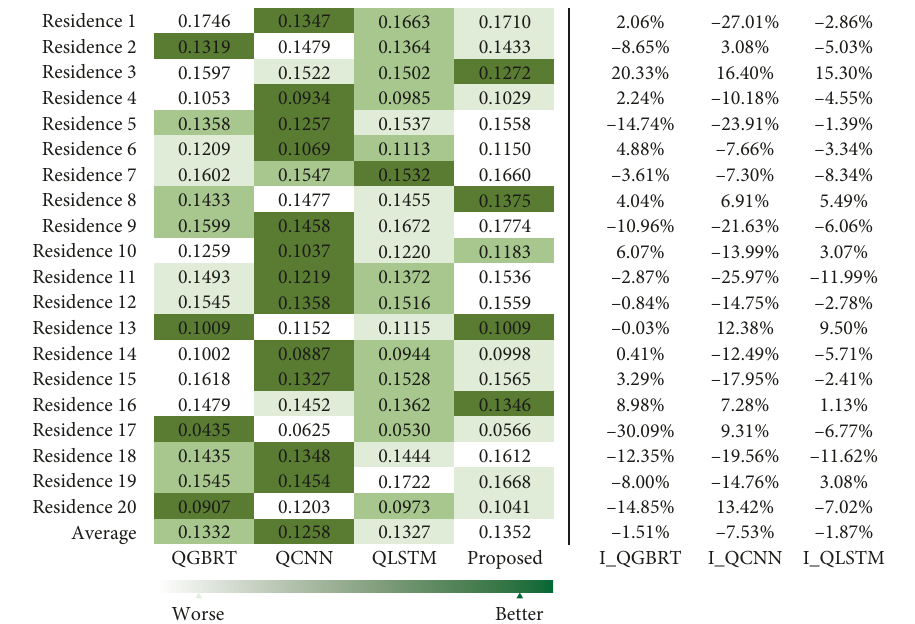
Figure 10: Heat map of the 80% PINAW for four models. QGBRT, QCNN, QLSTM, and our proposed model in X -axis correspond to PINAW, respectively, while I_QGBRT, I_QCNN, and I_QLSTM denote PINAW improvement ratio compared with our method over other models. Y -axis represents different residences. Results of each residence are compared in the same row, where darker green shades imply a better